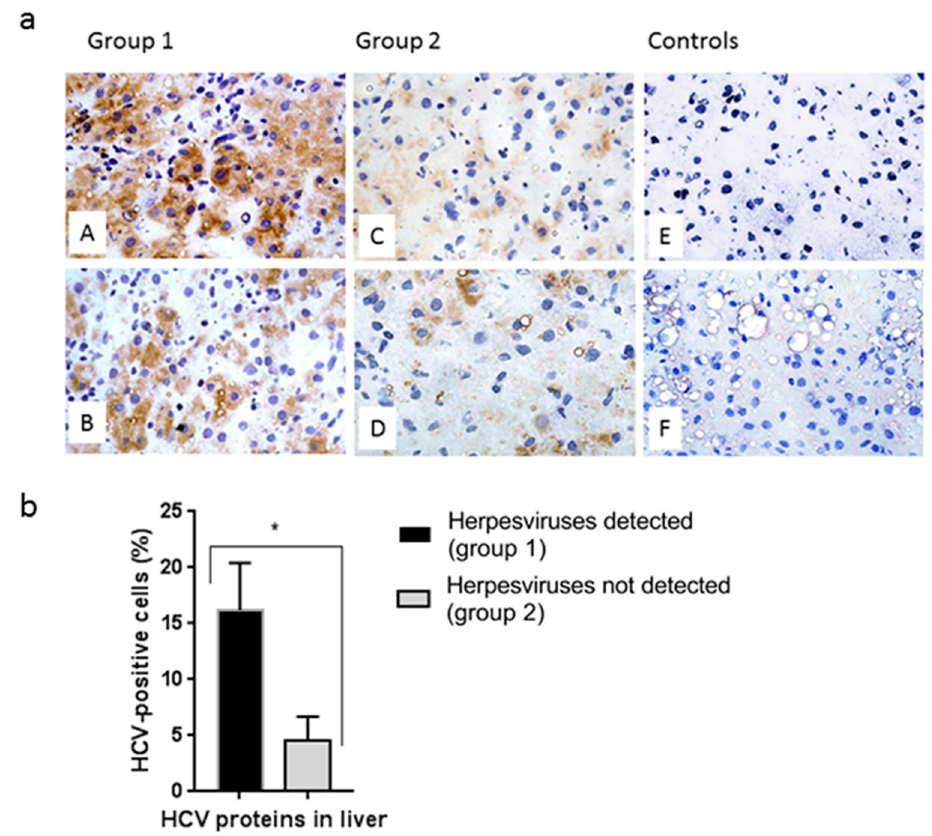
Figure 3. Comparative analysis of HCV proteins in hepatocytes of patients with chronic hepatitis C coinfected or not infected with herpesviruses. ( a ) Immunohistochemical detection of HCV proteins in cryostat liver sections using a mixture of mAbs to the core, NS3, NS4A/B, and NS5A proteins (A–D, F); E—mAb to HBsAg (negative control). A–E: patients with CHC, F: patient with steatohepatitis (negative control). Note more intensive cytoplasmic staining (brown) in group 1—HHV detected (A, B) compared with group 2—HHV not detected (C, D). No immunoreactivity was observed in the controls (E, F). The cell nuclei were stained with hematoxylin (blue). Magnification, × 400. ( b ) The relative number of HCV-containing liver cells in patients with CHC, depending on the detection of herpesviruses. Values are the means ± SEM (b), * p < 0.05 between groups.